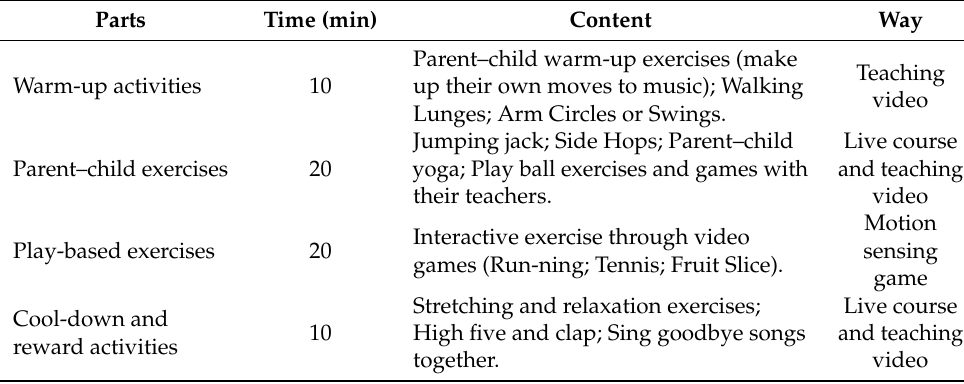
Table 2. Parent–child physical activity intervention